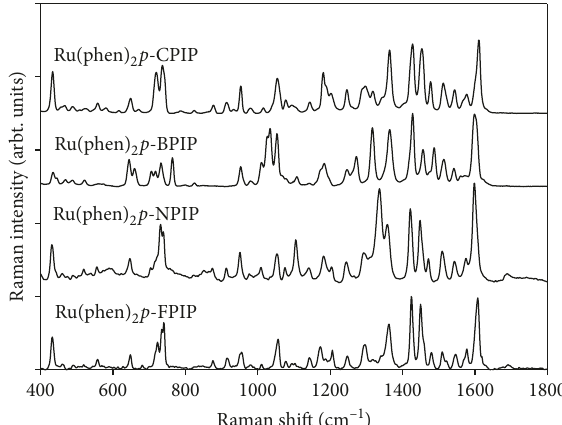
Figure 6: Solid-state Raman spectra of [Ru(phen) 273K and 785nm.